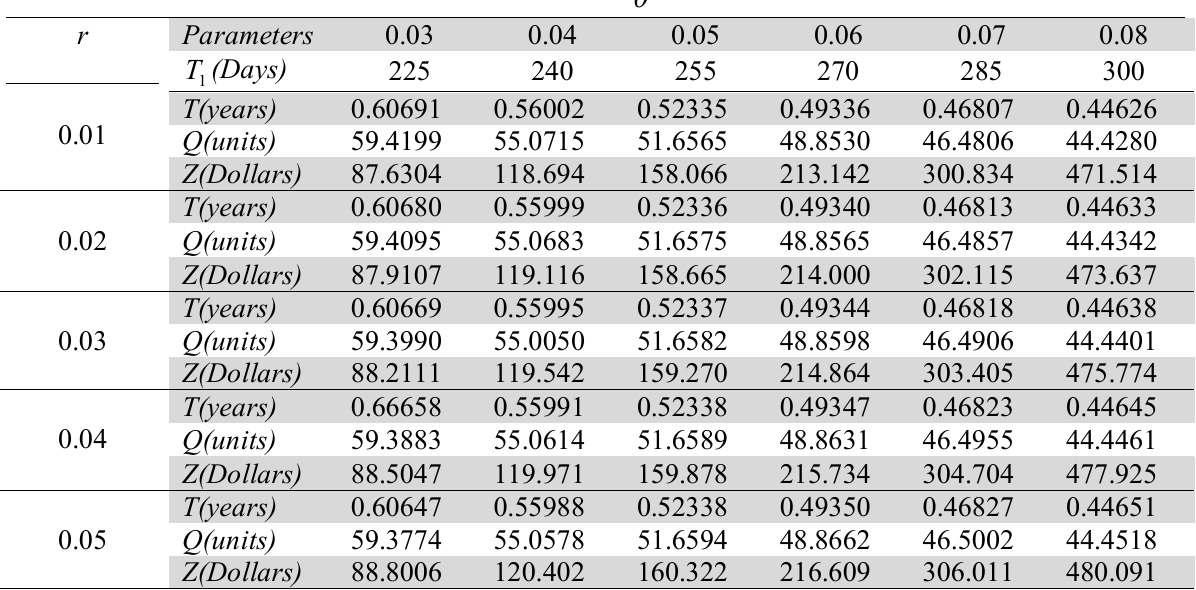
The results of optimal solution for different values of